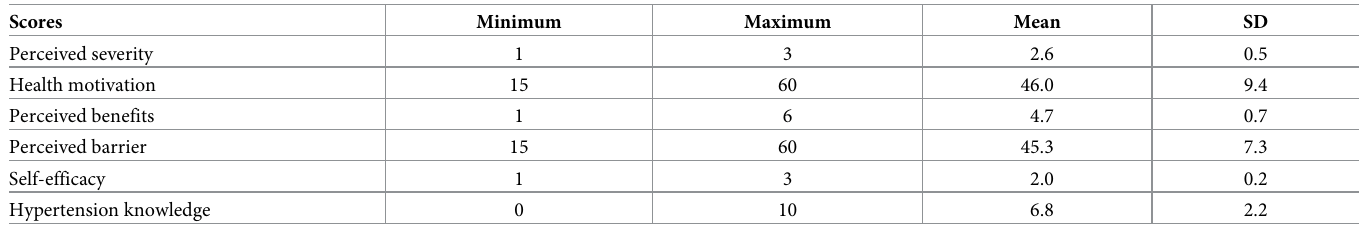
Table 2. Hypertension knowledge and Health Belief Model (HBM) predictor